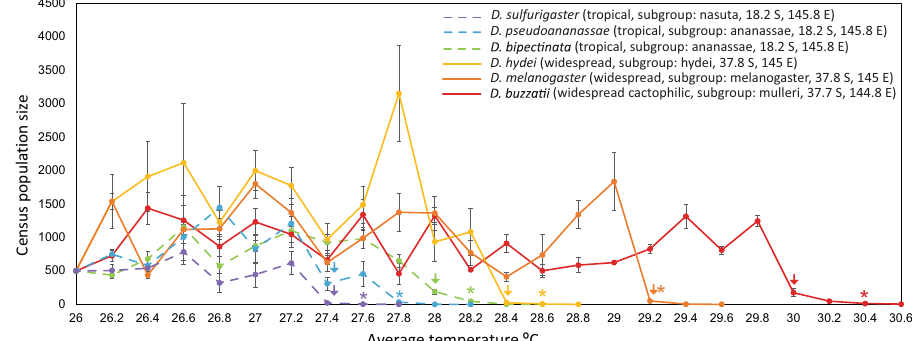
Fig. 1 Changes in population size and extinction in response to gradual warming in tropical (dashed lines) and widespread (solid lines) Drosophila species. Four replicate selection lines of D. bipectinata (green) , D. buzzatii (red) , D. hydei (yellow) , D. melanogaster (orange) , D. pseudoananassae (blue) and D. sulfurigaster (purple) were initiated under a fl uctuating temperature regime averaging 26 °C (±3 °C) and exposed to a 0.2 °C increase in average temperature every 2 weeks (approximately one generation). Census population size (±SEM) was estimated at the end of each 2-week warming period by assessing the census population size of each replicate line. Information on species ’ distributions, subgroup and collection locations is the key. Coloured arrows indicate when selected lines were signi fi cantly lower ( P < 0.05) than control populations (two-sided, independent samples t -test), and stars indicate when selected lines stopped reproducing/became sterile (scored when pupae were no longer present). Source data are provided as a Source Data fi le.